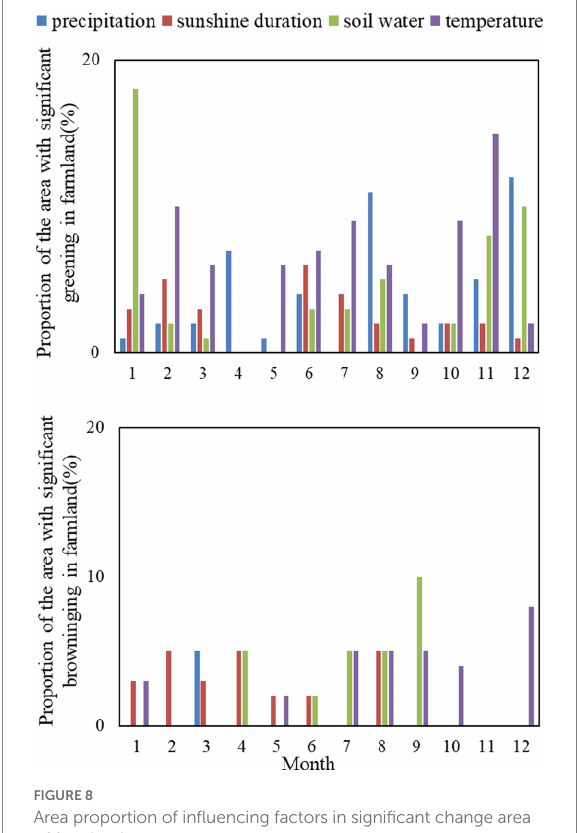
FIGURE 8 Area proportion of influencing factors in significant change area of